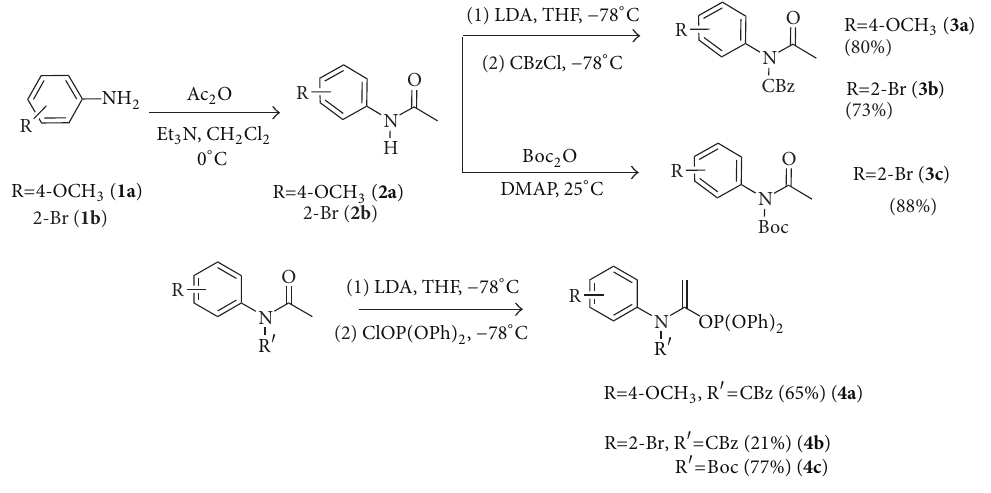
Scheme 1: Synthesis of the enol